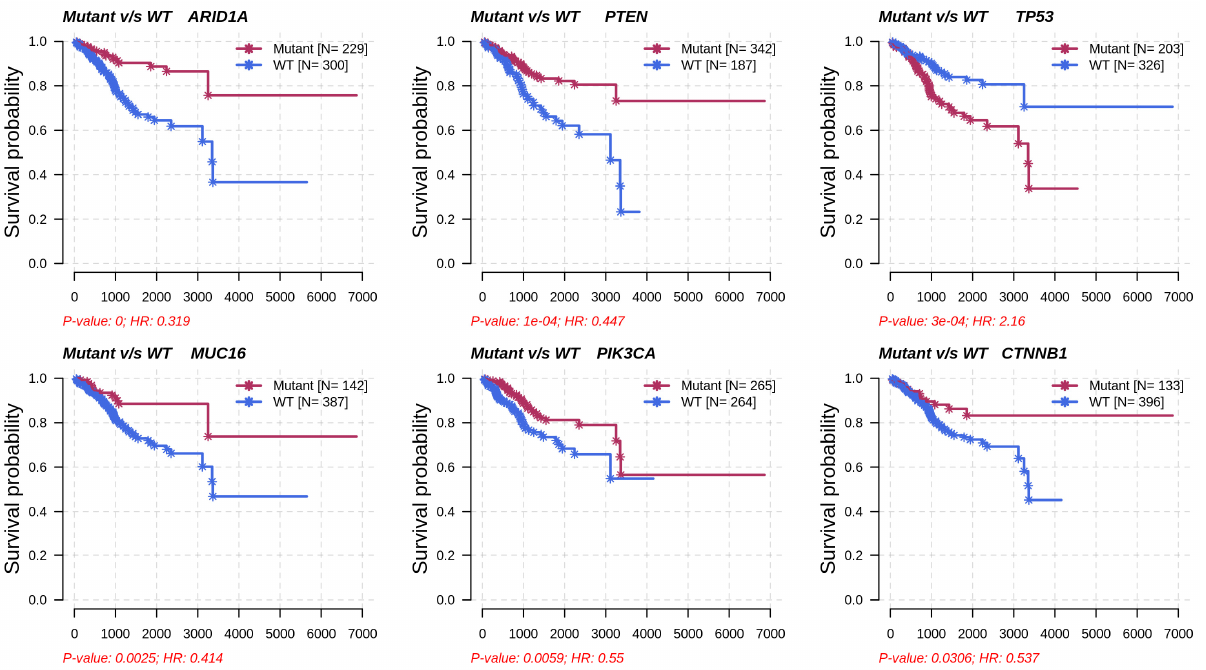
Figure 8. Survival analysis of frequently mutated genes in EC based on their mutation status. HR represents hazard ratio.